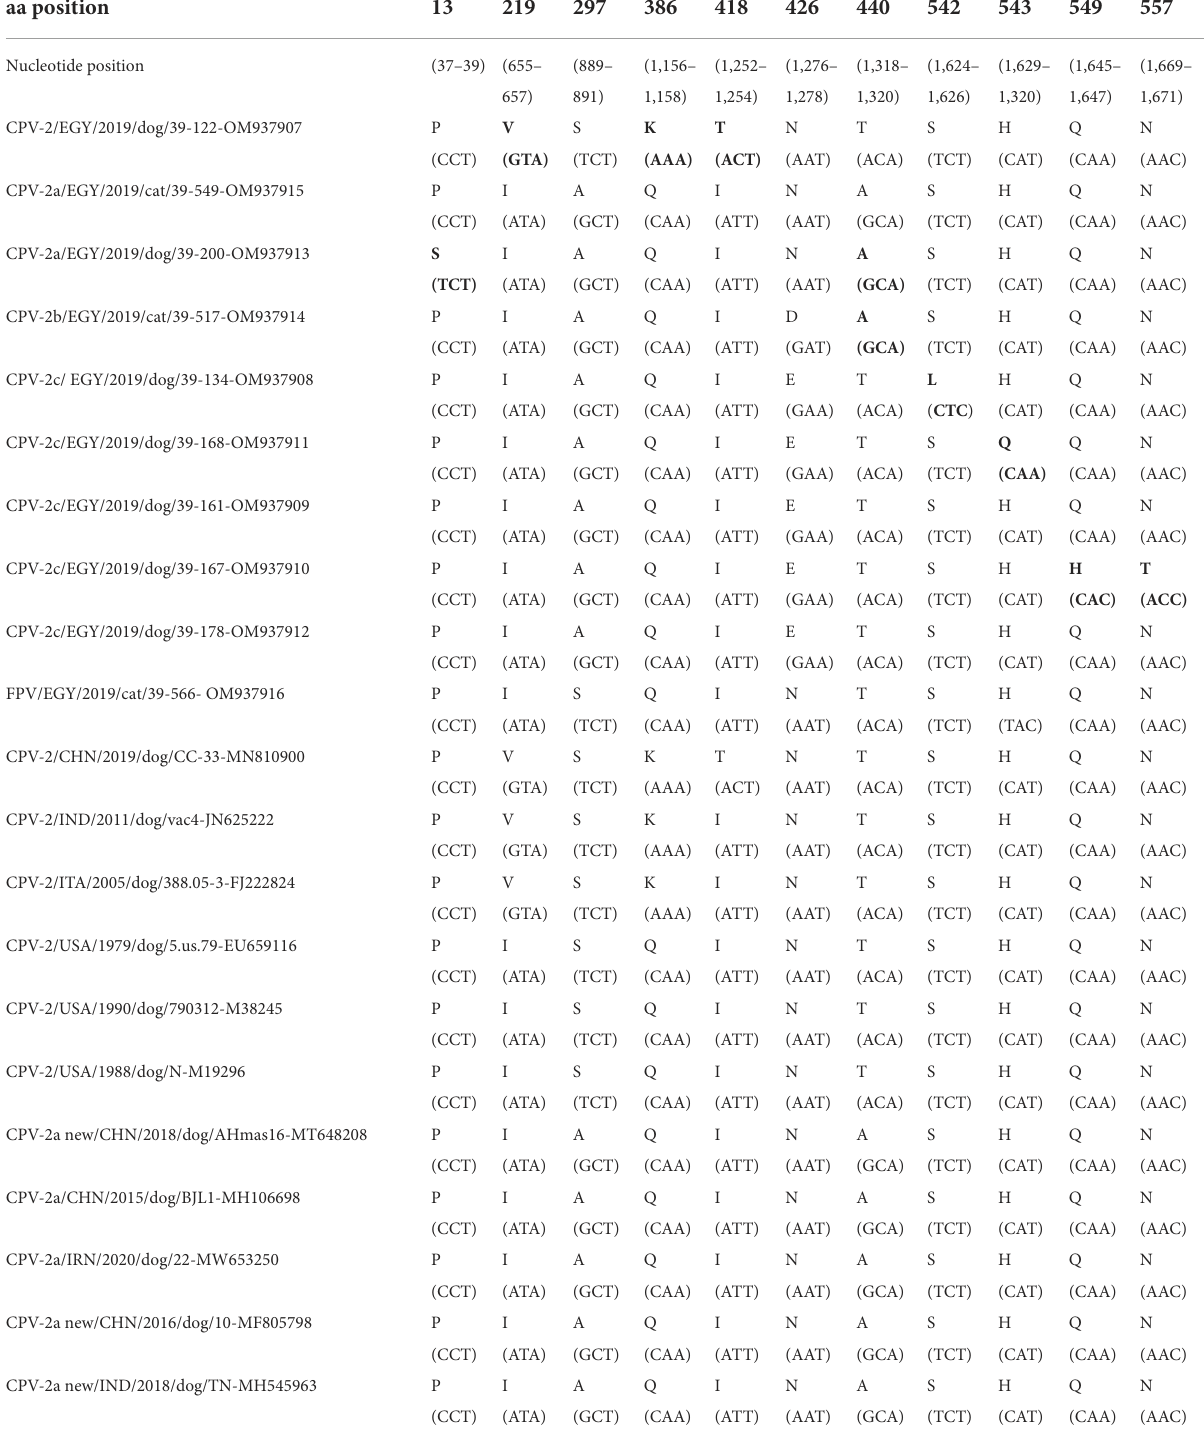
TABLE 2 Summary table of nucleotide and amino acid substitutions in the VP2 region of carnivore protoparvoviruses (canine parvovirus 2, CPV-2 and feline panleukopenia virus, FPV) detected in blood samples of dogs and cats in Egypt as compared to reference strains used for the phylogeny (Figure